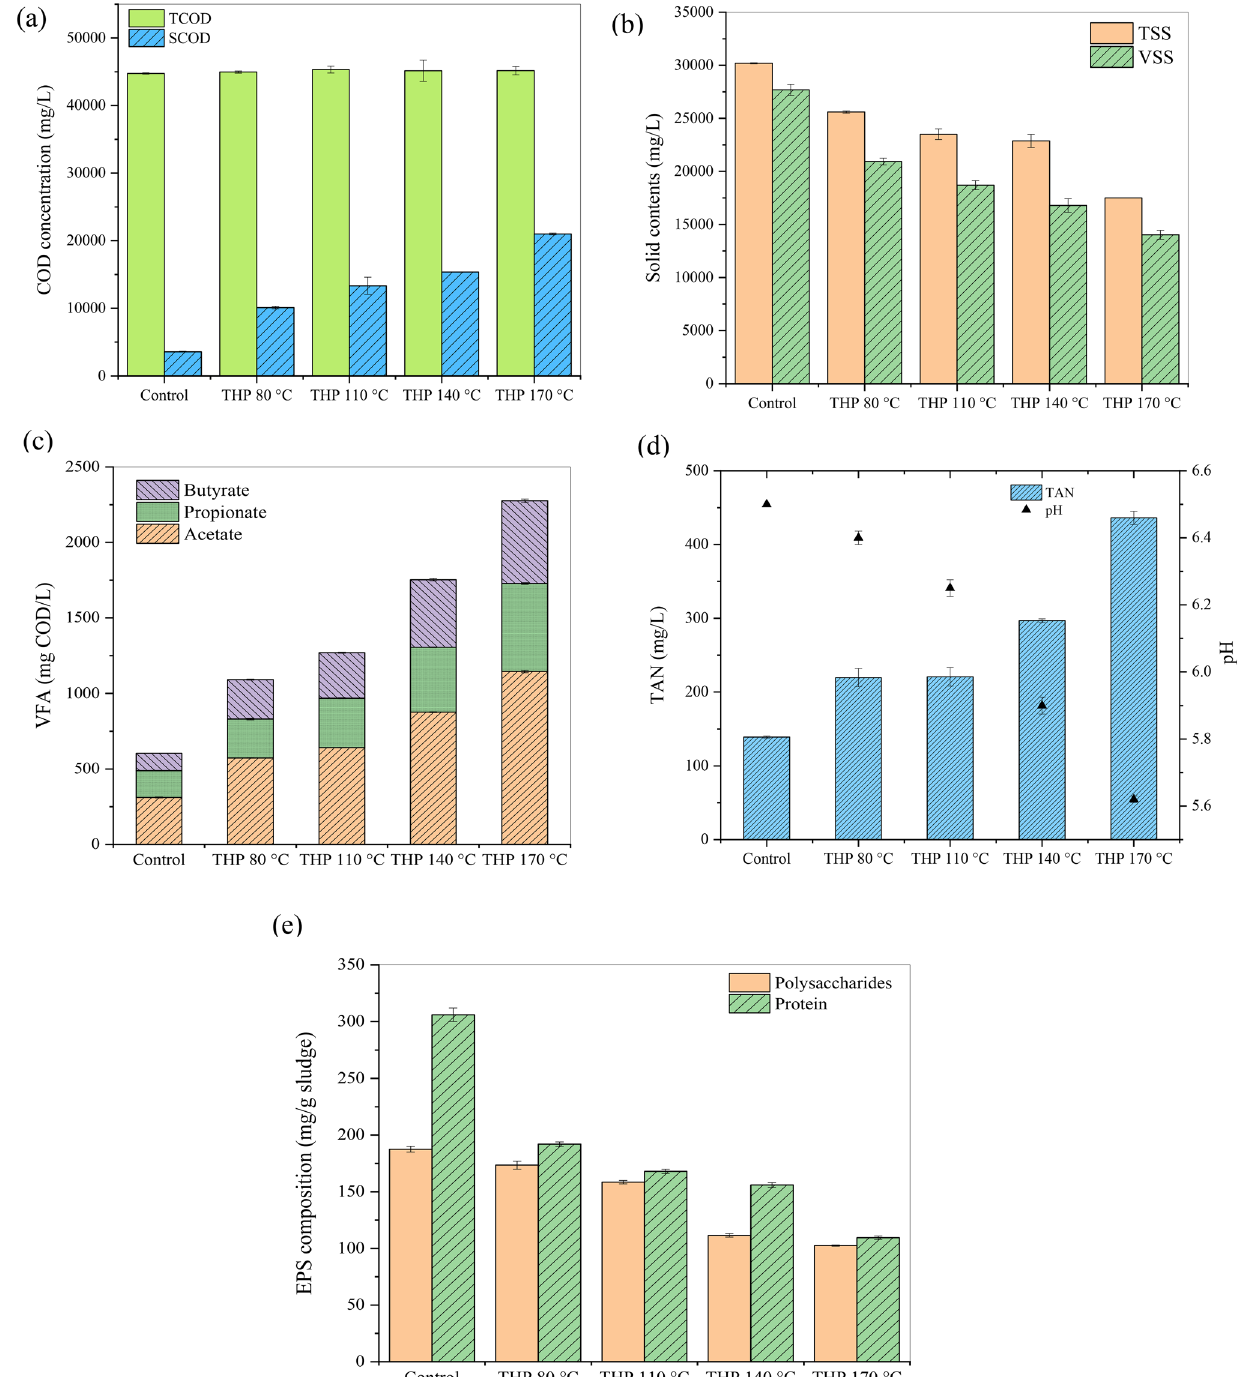
Figure 1. Effects of THP on ( a ) TCOD and SCOD, ( b ) TSS and VSS, ( c ) VFAs, ( d ) TAN, ( e ) EPS